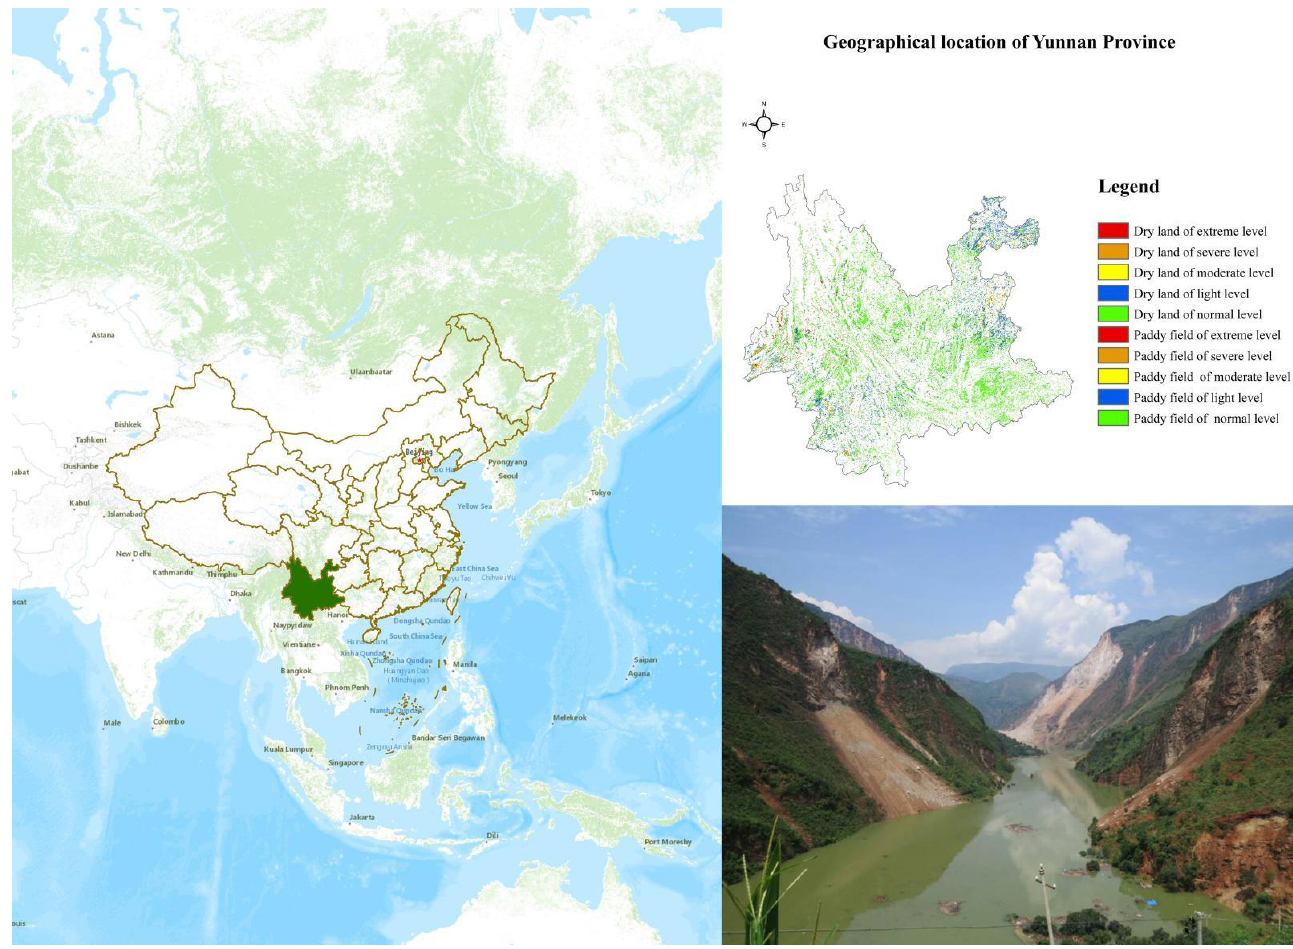
Figure 2. The location of the slope in the Hongshiyan water project.